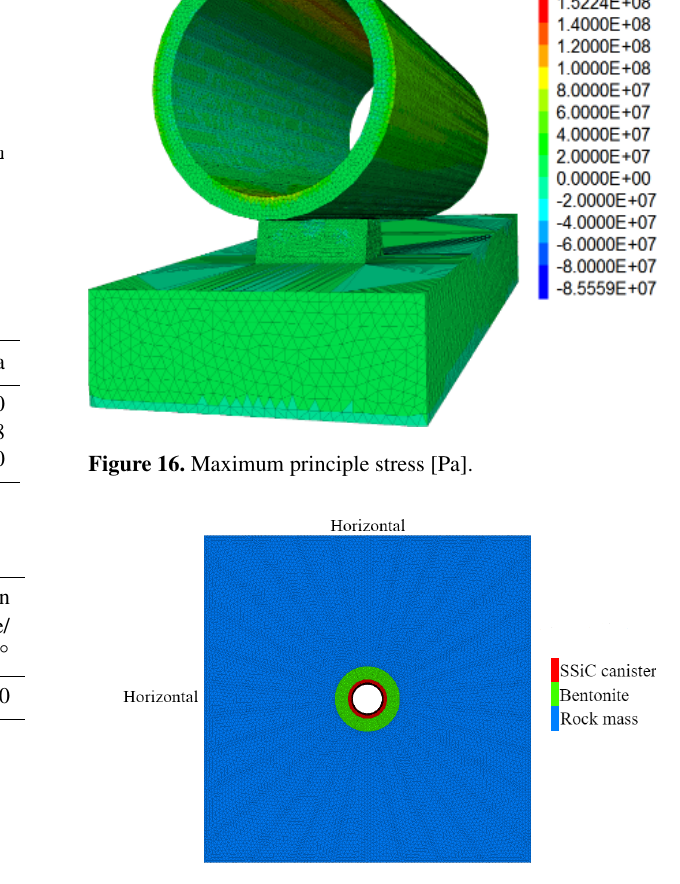
Figure 17. Model